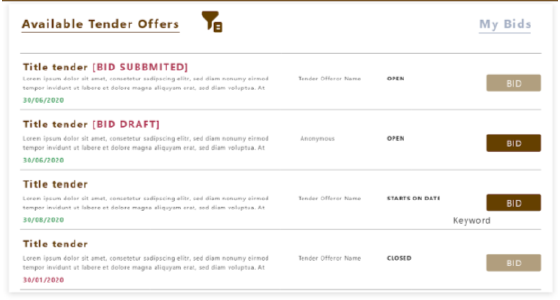
Figure A4. Available tender offers